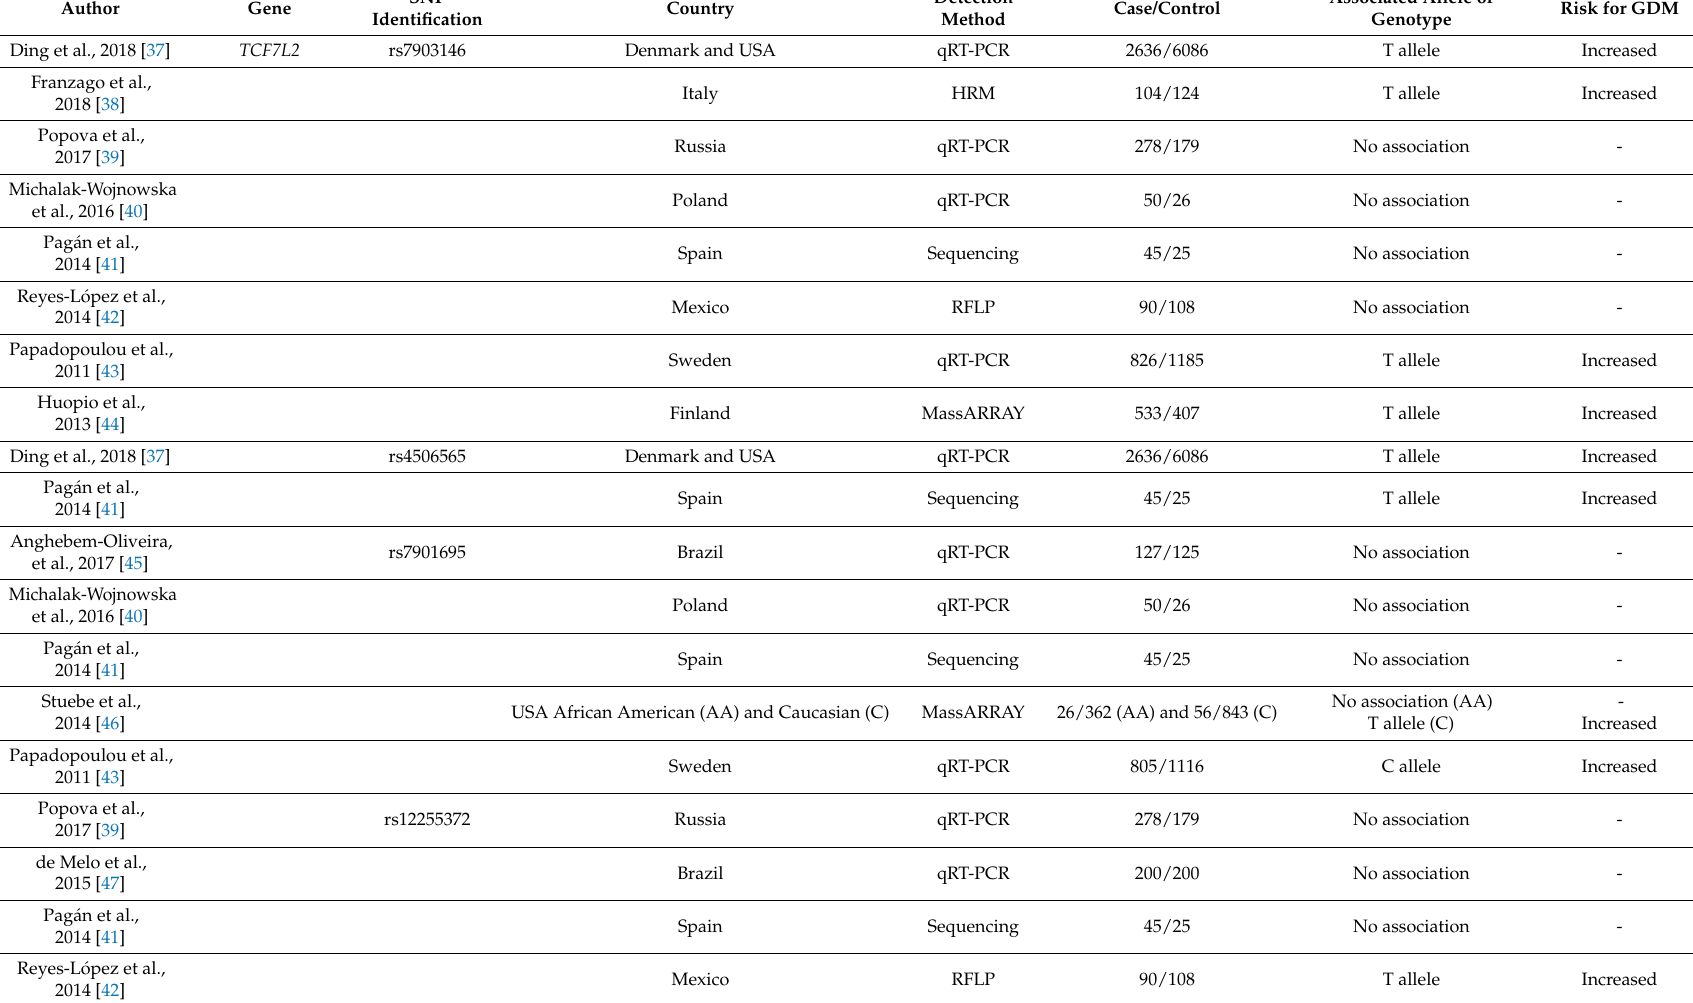
Table 1. Studies reporting on single-nucleotide polymorphisms (SNPs) profiled in two or more populations with gestational diabetes mellitus